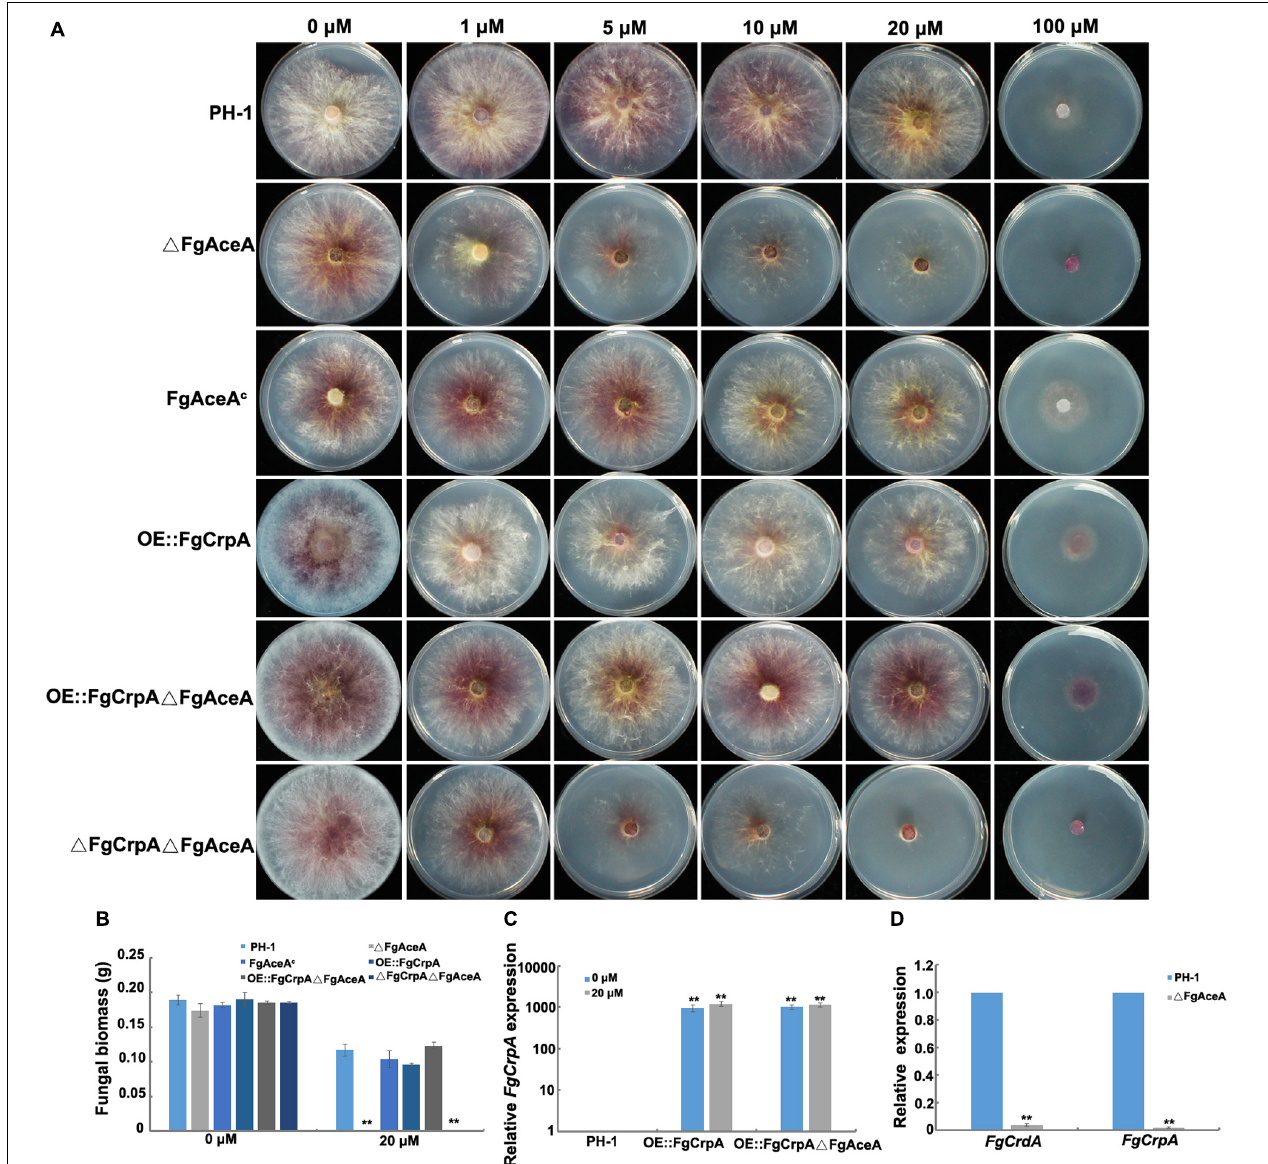
FIGURE 2 | Phenotypic analysis of (cid:77) FgAceA and its regulation on FgCrpA and FgCrdA . (A) Phenotypic characterization of the wild type strain PH-1 and mutants under Cu stress, equal numbers of conidia (2 × 10 3 ) were spot inoculated onto solidified FMM amended with CuSO 4 at different concentrations indicated in the figure and cultured at 25 ◦ C for 3 days. (B) Fungal growth was measured by determining the dry weight of the wild type strain PH-1, (cid:77) FgAceA, FgAceA c , OE:FgCrpA, OE:FgCrpA (cid:77) FgAceA, and (cid:77) FgCrpA (cid:77) FgAceA grown in liquid FMM amended with or without CuSO 4 at 20 µ M in a shaker at 180 rpm at 25 ◦ C for 3 days. A t -test was performed to determine significant differences, ** p < 0.01. (C) Relative expression of FgCrpA in OE:FgCrpA or OE:FgCrpA (cid:77) FgAceA analyzed by qRT-PCR assays. (D) Relative expression of FgCrpA and FgCrdA in (cid:77) FgAceA analyzed by qRT-PCR